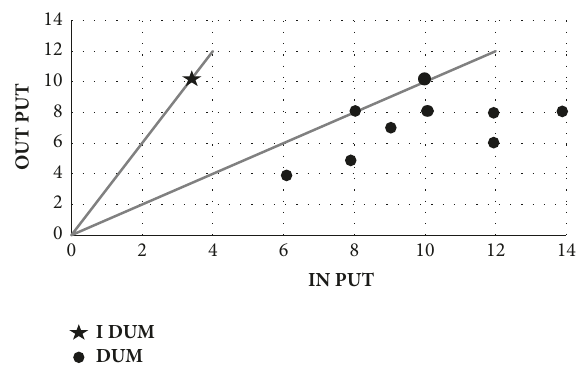
Figure 3: Efficient frontiers by the ideal DMU and efficient units.